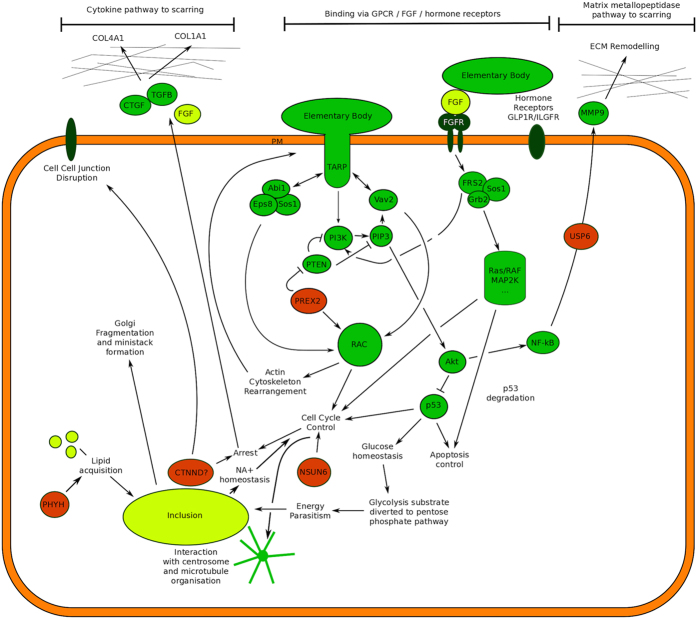
Trachoma associated genes and pathways.Potential roles for candidate genes (red) that were identified through this
GWAS are indicated. Various significant cell surface receptors pathways
including FGFR, GPCR, ILGFR1 and GLPR1 are linked to cell cycle control by
PI3K/Akt/p53 signalling. Chlamydial elementary bodies are known to interact
with this system via sos1 and vav2. Downstream signalling from these
pathways can lead to actin remodelling (facilitating cell entry), cell cycle
arrest and inhibition of apoptosis; all factors that facilitate parasitism.
Glucose and sodium ion homeostasis resulting from p53/cell-cycle control may
increase nutrient availability to the growing inclusion. Up-regulation of
NFKB, CTGF, MMP9 and TGFB are potential routes to
fibrosis.